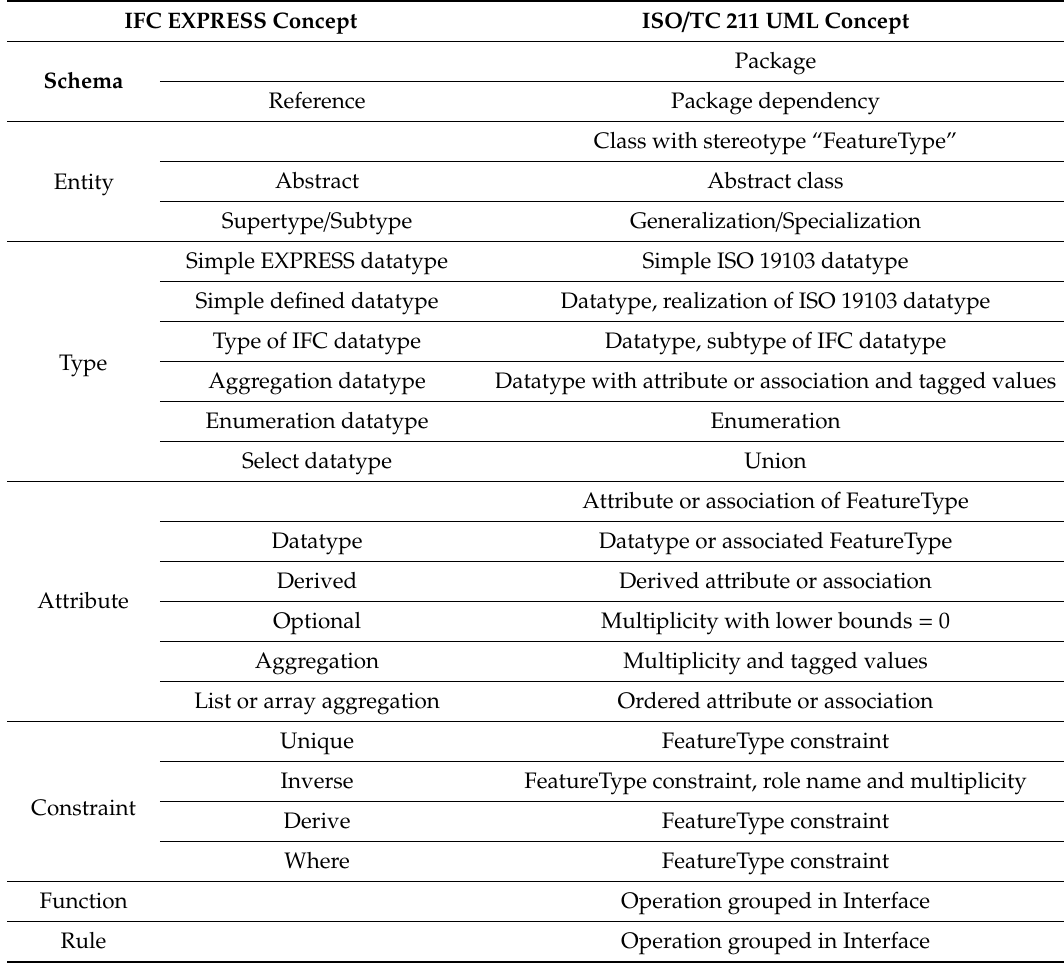
Table 3. Overview of the conversion